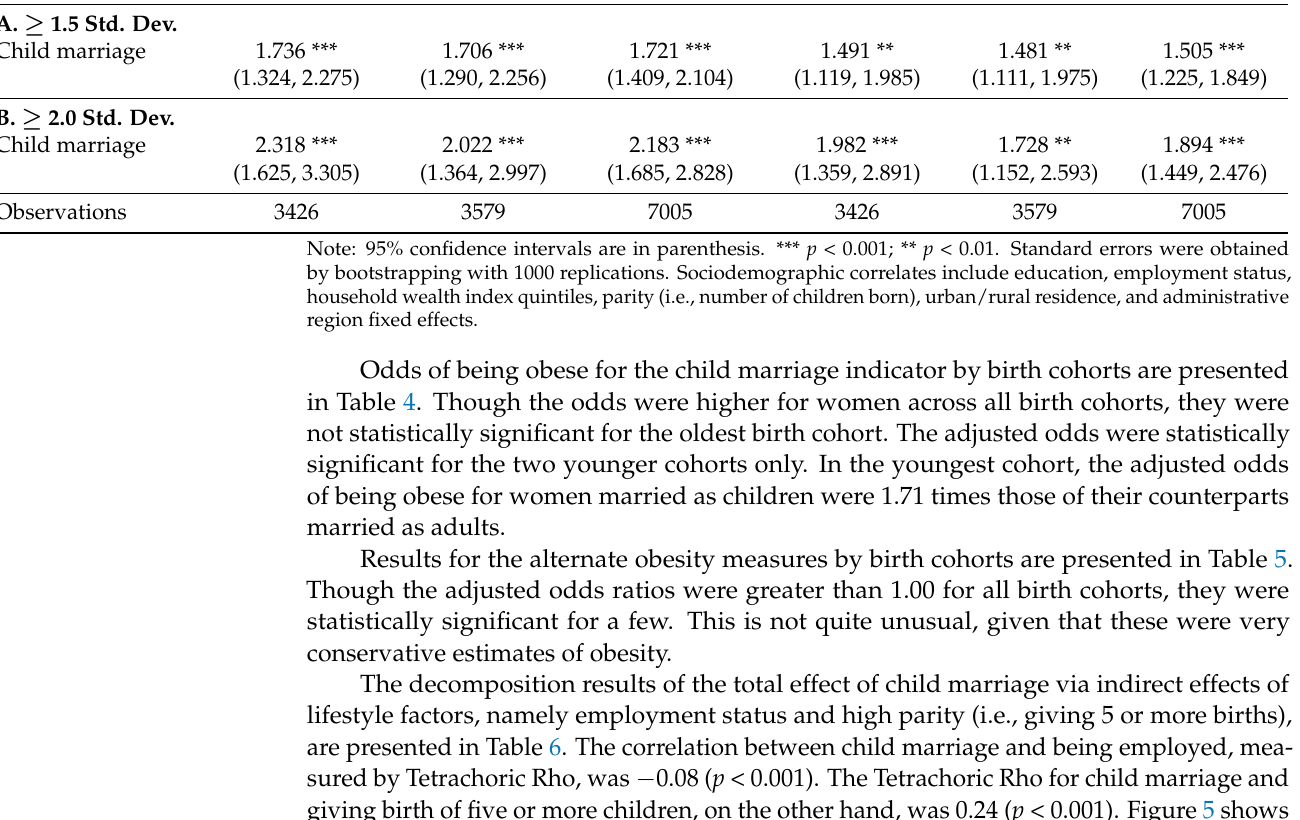
Table 3. Odds ratios in favor being obese (alternate measure) for the full sample. Not Adjusted for Sociodemographic Correlates Adjusted for Sociodemographic Correlates 2012 Wave 2017 Wave Both Waves 2012 Wave 2017 Wave Both